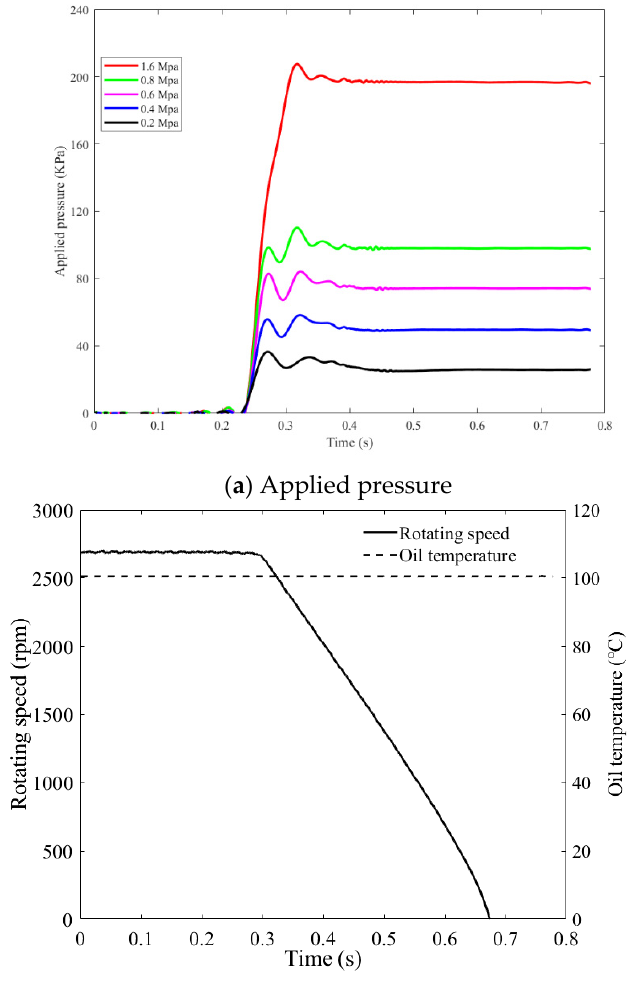
Figure 10. Experiment conditions.